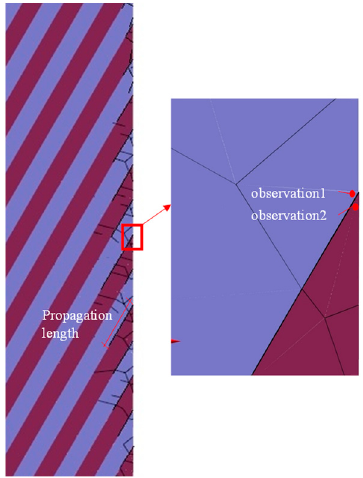
Figure 8. Schematic diagram of the initial fracture and length propagation in a − 75° rock stratum.